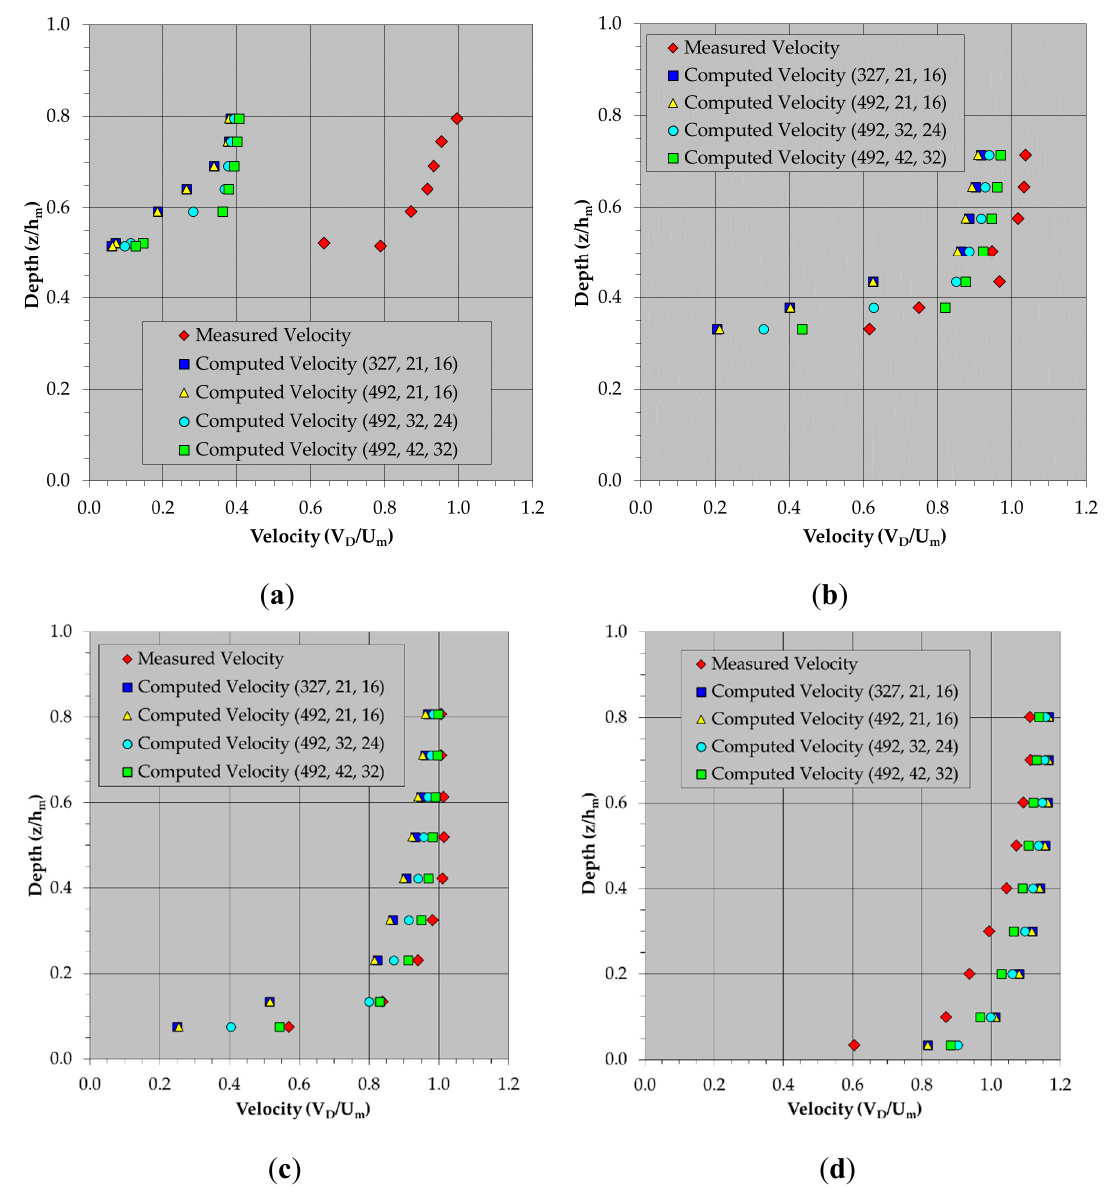
Figure A14. Cont